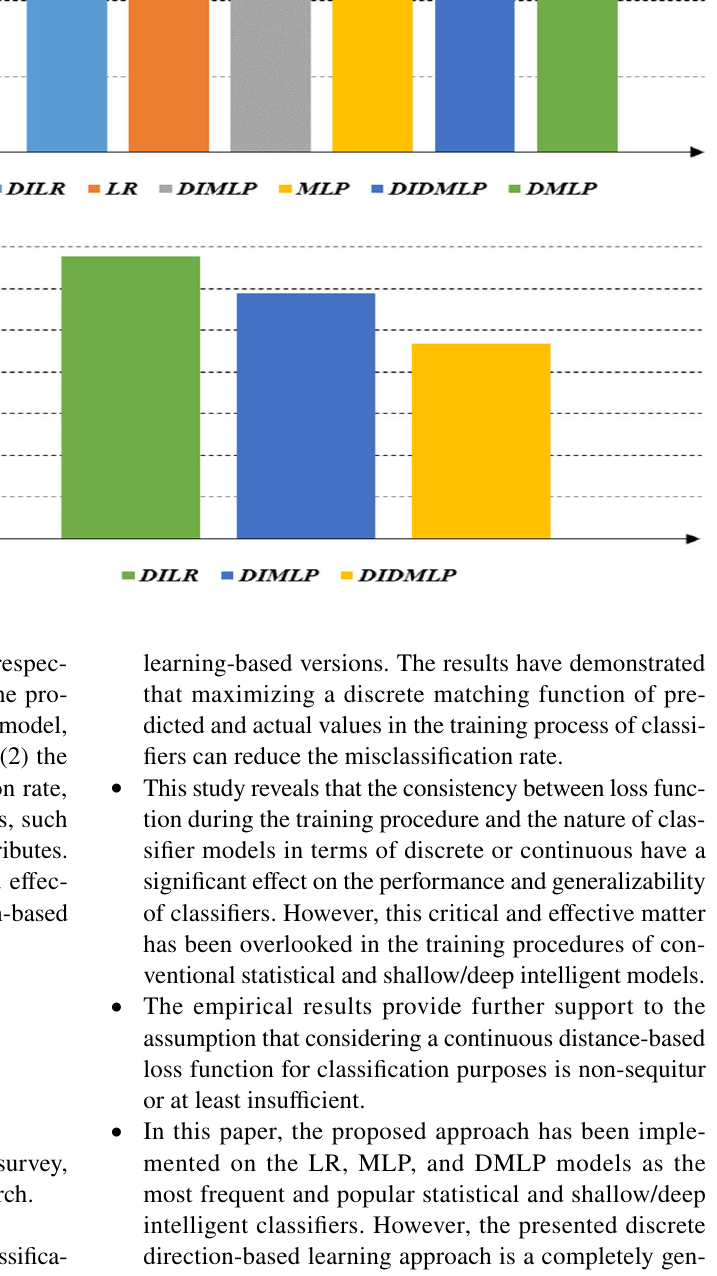
Fig. 3 The classification rate and improvement of the DILR, DIMLP, and DIDMLP against conventional